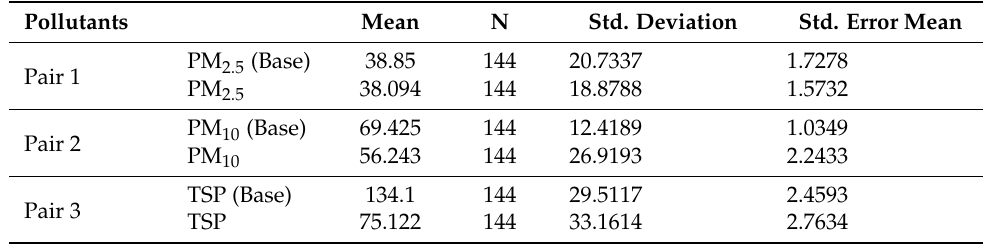
Table 1. Descriptive statistics (means in µ g/m 3 ).